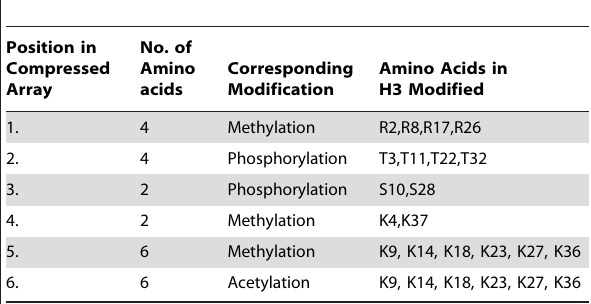
Table 2. Compression of H3 type